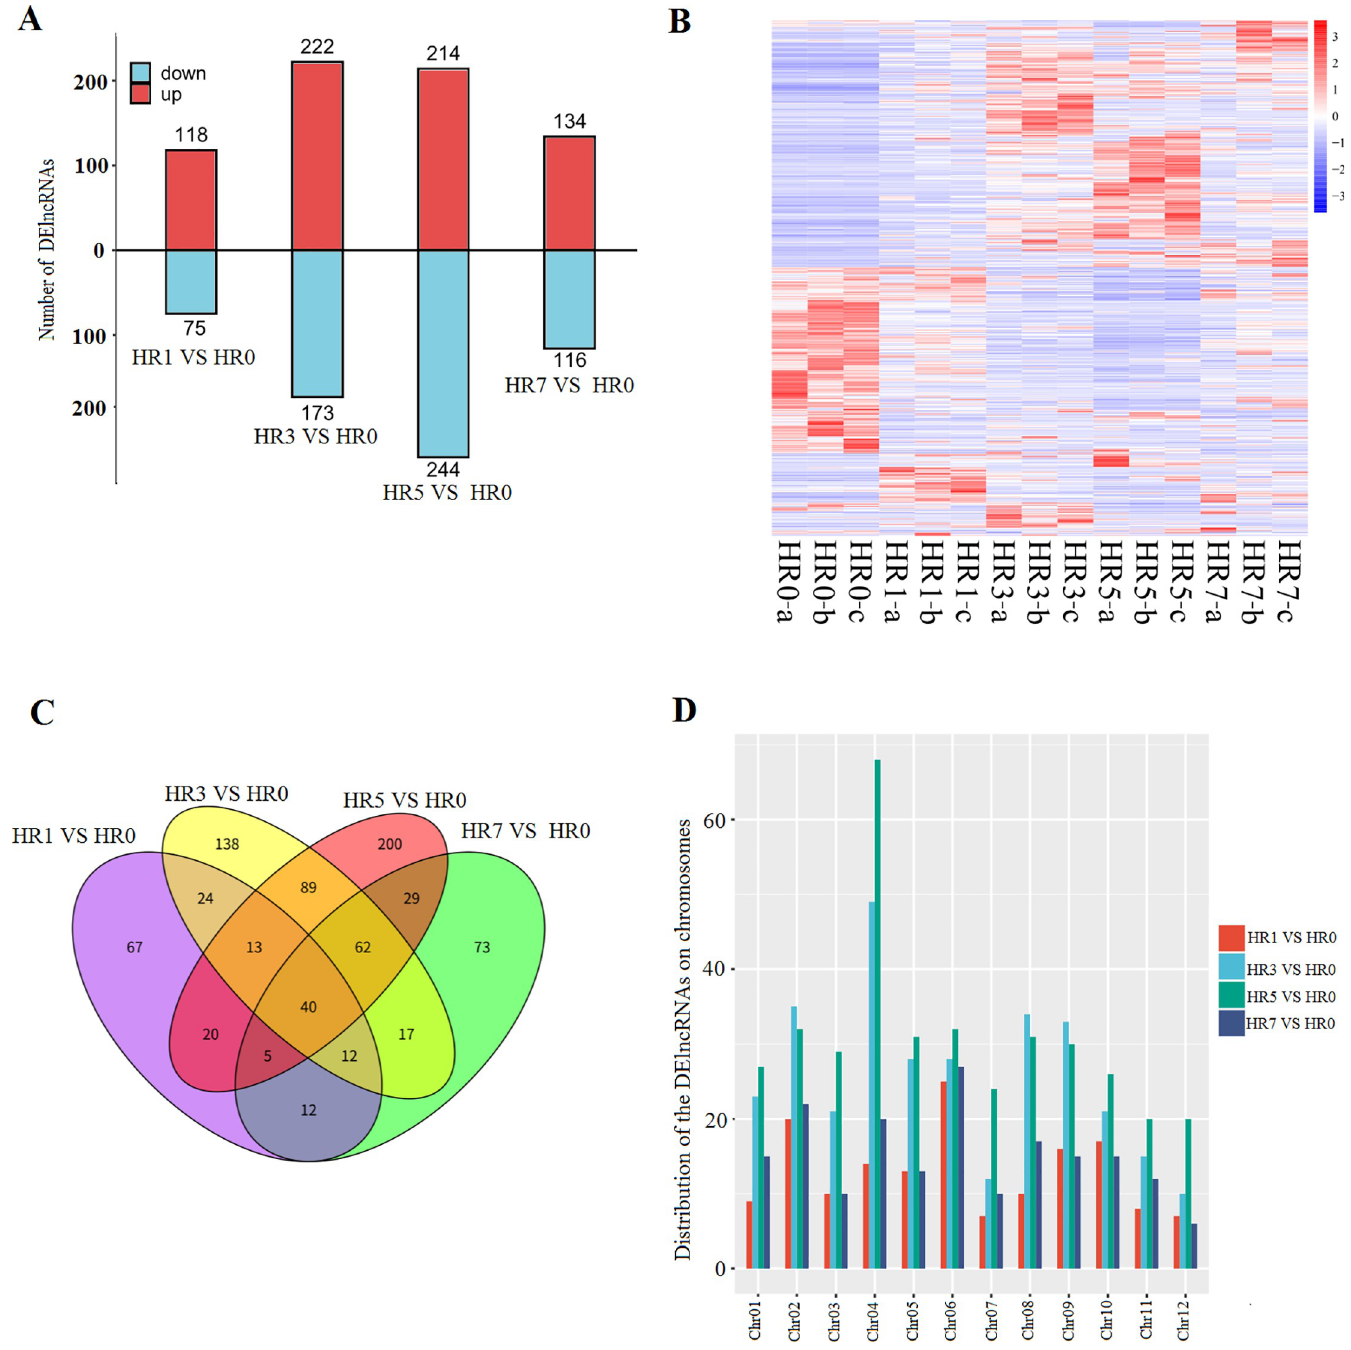
Fig 2. Exploration of differentially expressed (DE) lncRNAs in response to heat stress (HS). (A) The number of up-regulated and down-regulated DE lncRNAs from the four comparisons (HR1 VS HR0, HR3 VS HR0, HR5 VS HR0 and HR7 VS HR0). (B) Hierarchical clustering heatmap of all DE lncRNAs from the four comparisons. (C)Venn diagram showing the overlapping DE lncRNAs from the four comparisons. (D) Barplot showing the distribution of DE lncRNAs on chromosomes from Hqing1-HR cultivar of Z . jujuba .